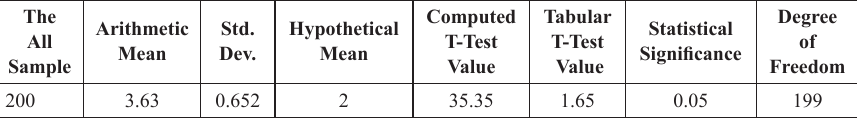
Table 1. The mean and the T-value (questions (correction 1.0))